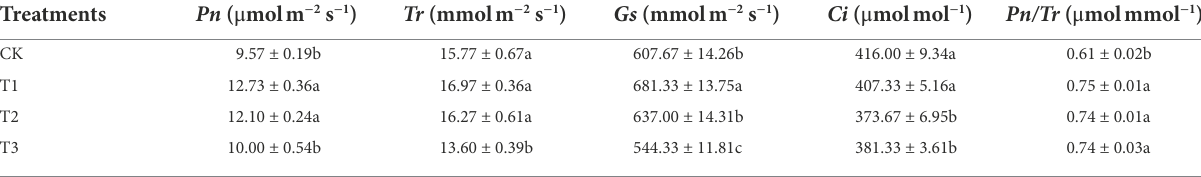
n = 3, different letters indicate significant differences ( P <